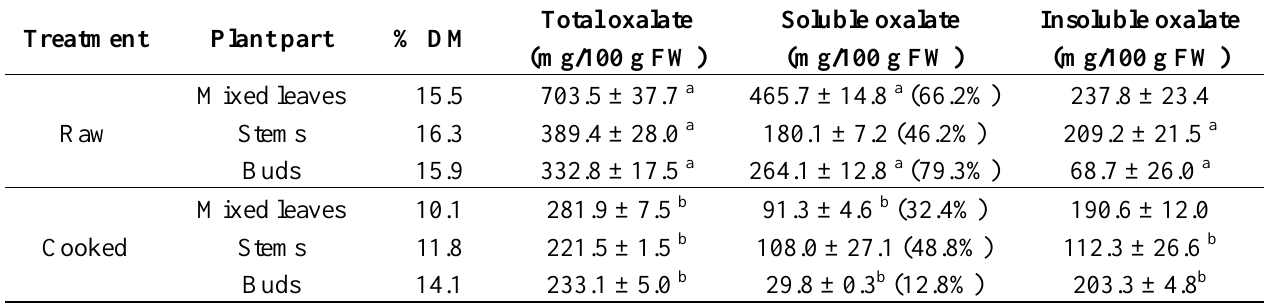
Data for the mixed leaves, stems and buds with a different superscript for the raw and cooked samples are significantly different ( p <